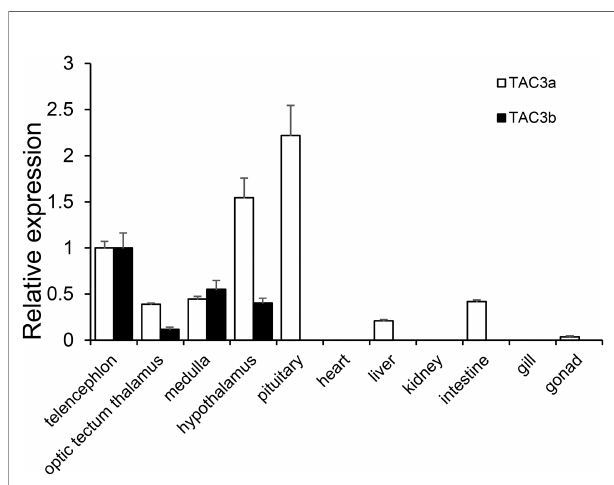
FIGURE 4 | Expression of tac3s mRNAs in various tissues (telencephalon, optic tectum thalamus, medulla, hypothalamus, pituitary, heart, liver, kidney, intestine, gill, and gonad) of Japanese eel. The X-axis indicates different tissues. The results are normalized to 18s rRNA. The data are shown as the mean ± S.E.M (n = 3), and the mRNA levels of tac3a and tac3b were calculated as fold change relative to the mRNA levels of the heart. The different lowercased letters indicated signi fi cant differences (P < 0.05). in zebra fi sh (22), gold fi sh (23), spotted sea bass (29), and European eel ( Anguilla anguilla ) (42).